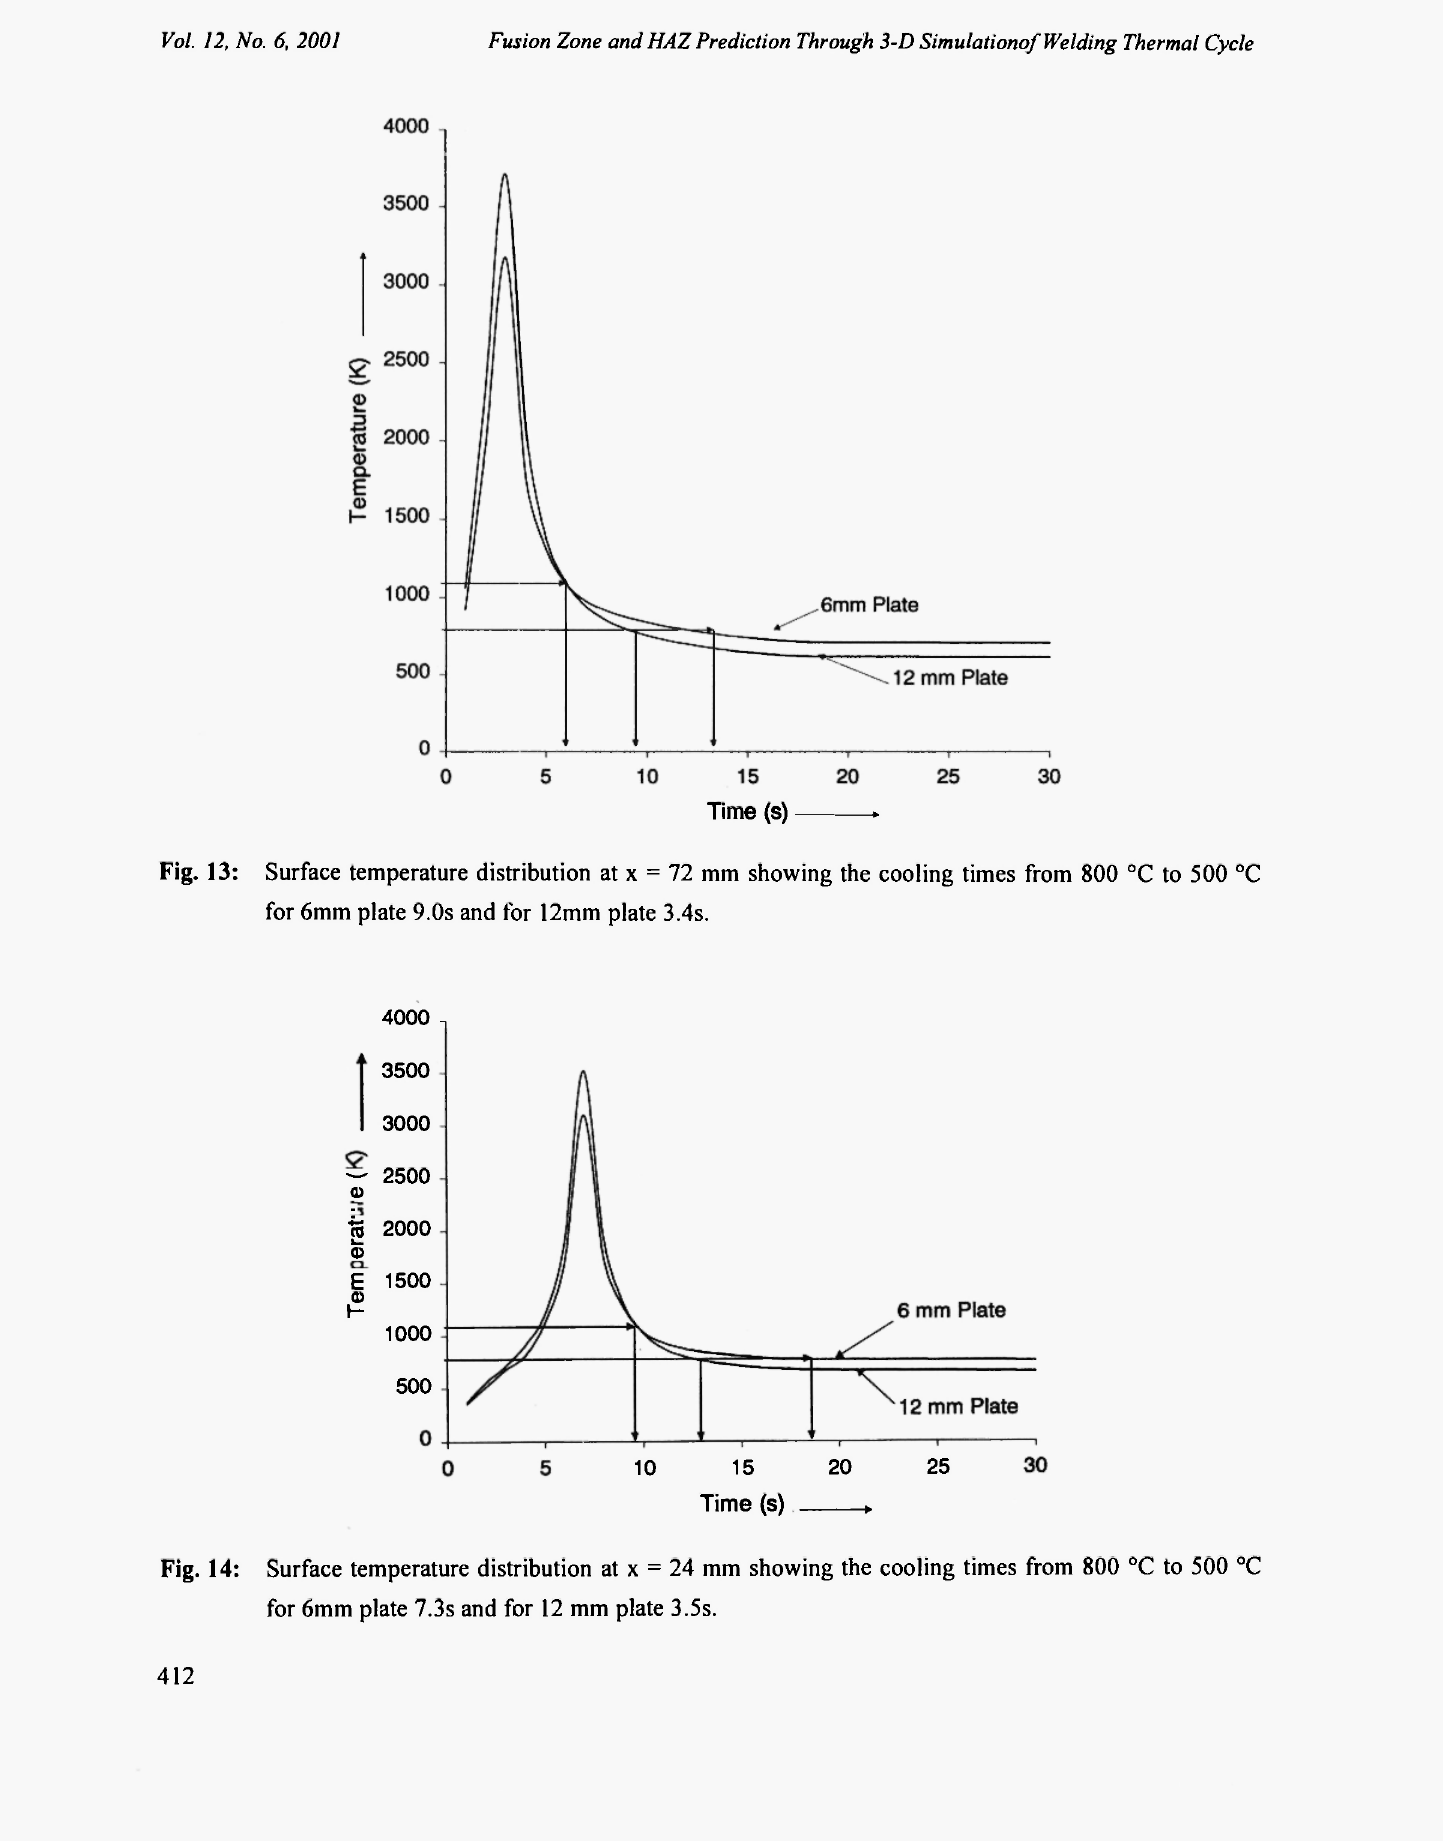
Fig. 14: Surface temperature distribution at χ = 24 mm showing the cooling times from 800 °C to 500 °C for 6mm plate 7.3s and for 12 mm plate